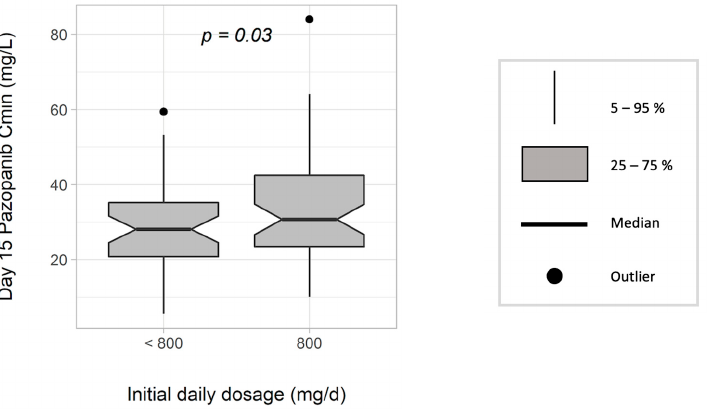
Figure 2. Trough (C min ) concentration of pazopanib at D15 according to the starting dose (mg/day) (n = 95).